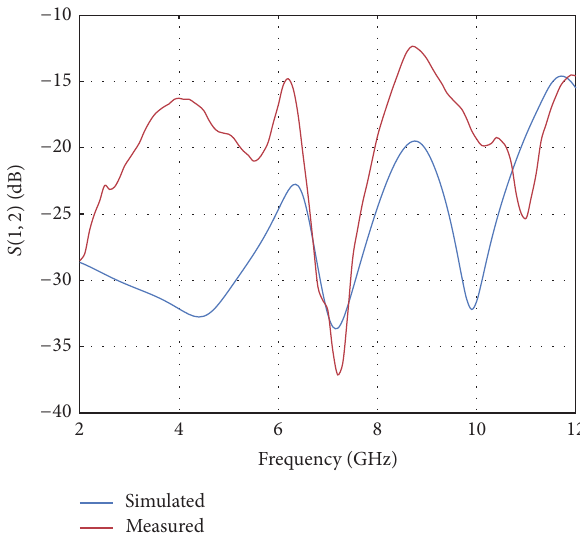
Figure 19: Comparison of simulated and measured transmission coefficients between the UWB and the first NB antenna ports.